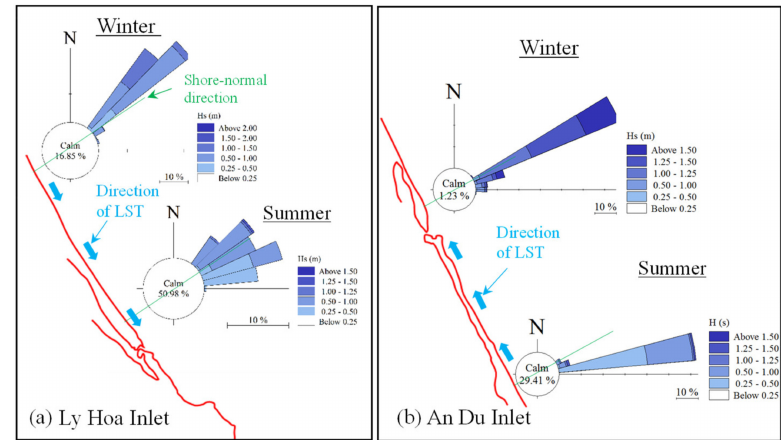
Figure 12. Wave roses at the nearshore area from Delft3D model results at ( a ) the Ly Hoa Inlet, ( b ) the An Du